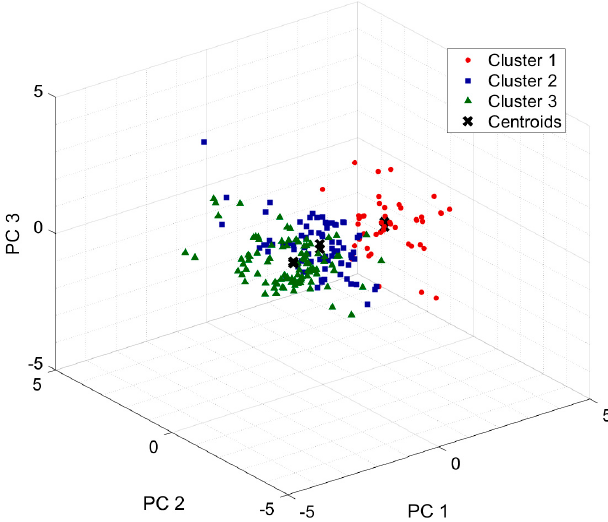
Figure 11. Cluster analysis results.